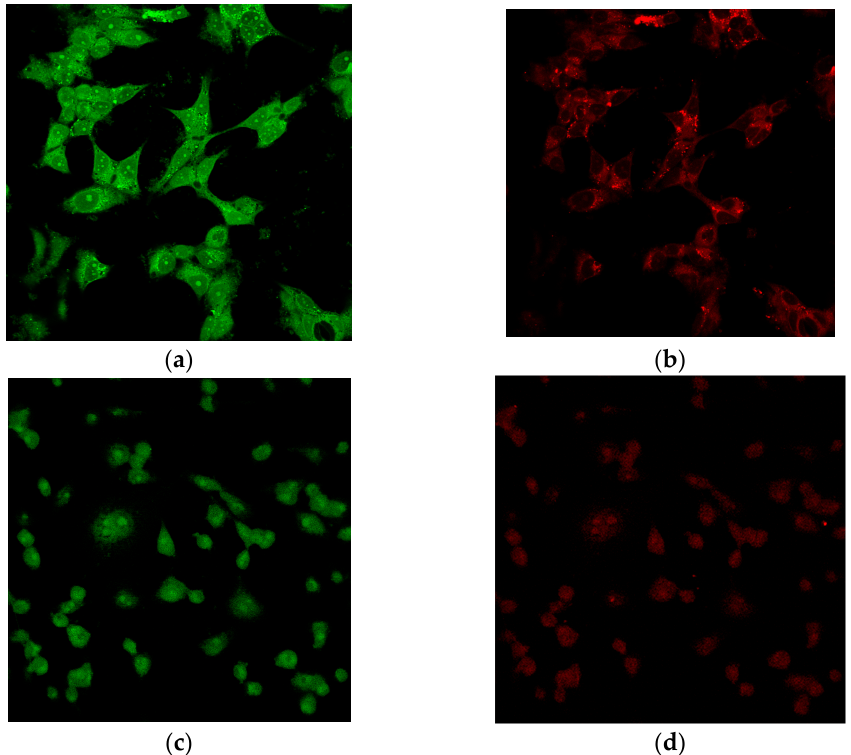
Figure 6. Confocal laser scanning microscope images of tumor cells with 3ZnPc: ( a ) MCF-7 cells (scale: exc: 405 nm; em: 450–550 nm); ( b ) incubated 3ZnPc (scale: exc: 635 nm; em: 670–780 nm); ( c ) MDA-MB-231 cells; and ( d ) 3ZnPc studied at the spectral conditions as ( a , b ) ×63.